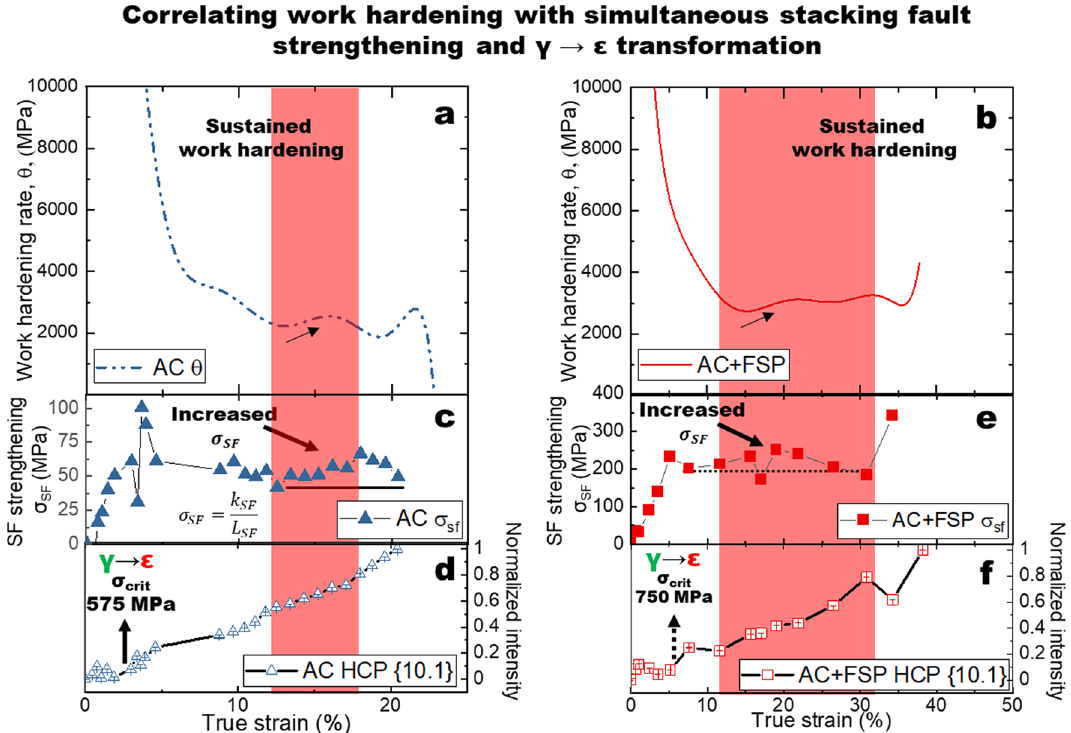
Figure 4. The work hardening behavior of Fe 40 Mn 20 Cr 15 Co 20 Si 5 high entropy alloy. Work hardening curves for ( a ) as-cast (AC) and ( b ) friction stir processed (AC + FSP) conditions. The stacking fault strengthening, σ SF , (for ( c ) AC and ( e ) AC + FSP, respectively) and intensity of the ε-h.c.p. {10.1} intenstiy (for ( d ) AC and ( f ) AC + FSP, respectively) as a function of true strain. The transition in deformation behavior is observed by the plateau in σ SF (marked by horizontal black lines) the coincident increase in the ε-h.c.p. phase fraction marked by the increase in intensity of the